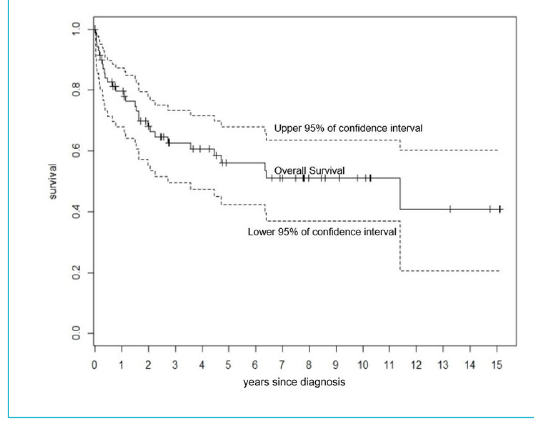
Figure 2: Overall Survival from post-transplant lymphoproliferative disorder diagnosis for both cohorts